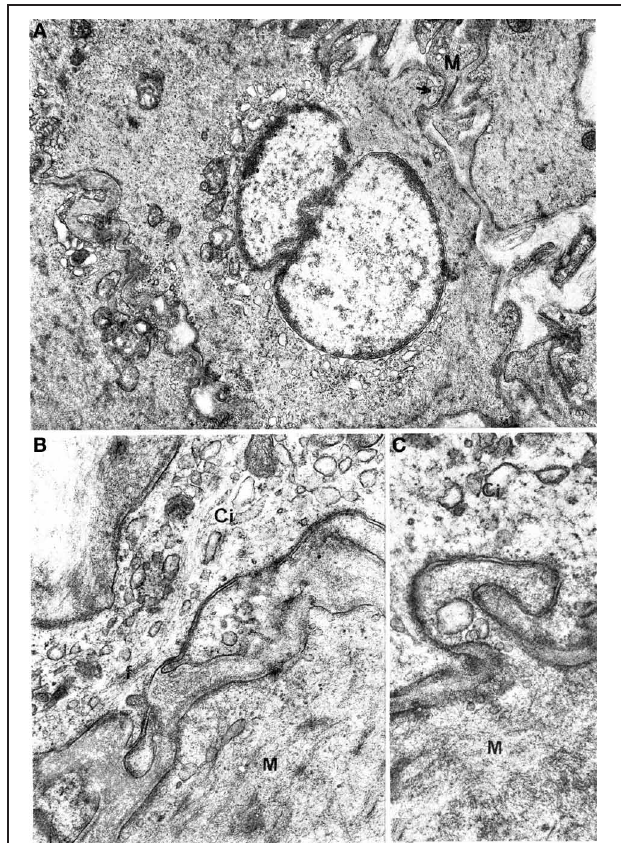
FIGURE 4 | Gastric muscle coat. (A) A cell that is highly similar to a typical muscle cell but with a well-developed smooth endoplasmic reticulum near the nucleus. The arrow points to a close contact with a muscle cell (M). × 13,500. (B) A process of an interstitial cell (Ci) that is rich in vesicles of smooth endoplasmic reticulum and contains a bundle of filaments (f) parallel to the cell major axis. M: muscle cell. × 21,500. (C) Detail of a contact between an interstitial cell (Ci) and a muscle cell (M), without interposition of a basal lamina; × 21,500.